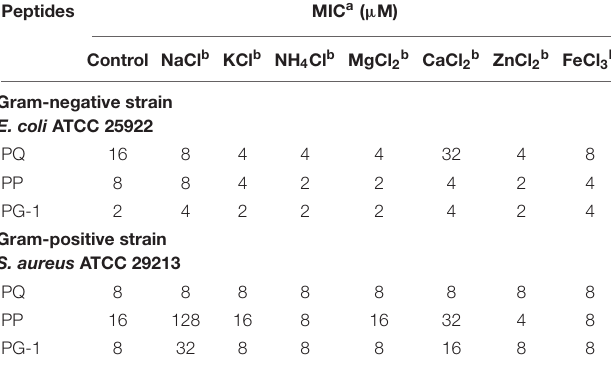
TABLE 4 | Minimum inhibitory concentrations values of peptides in the presence of physiological salts a . Peptides